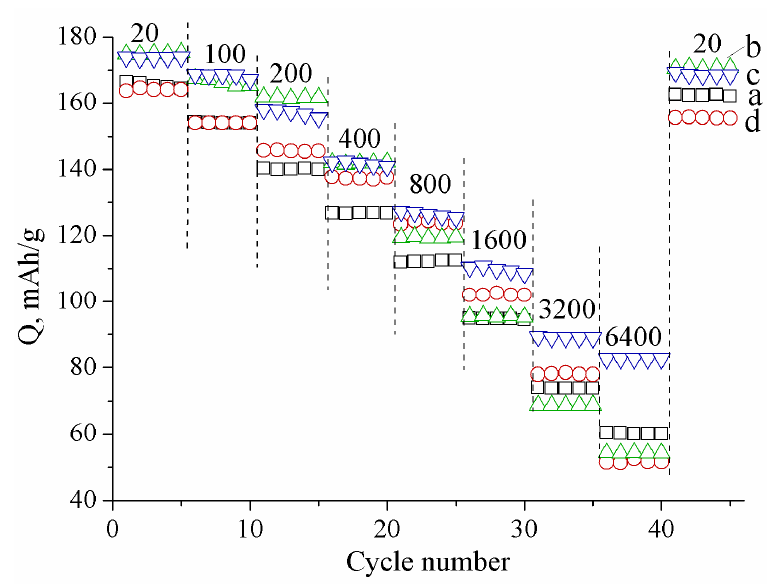
Figure 5. Cycling performance of the LTO ( a ), LTO / 5%G_157M ( b ), LTO / 5%CB ( c ), and LTO / 5%CR ( d ) samples. The current densities (mA / g) are shown in the Figure.